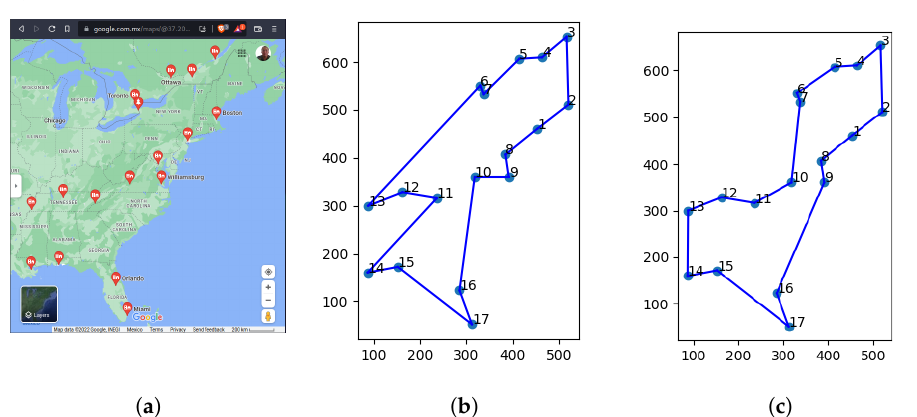
Figure 30. Map and solution of instance “ EastUSA.tsp ”. ( a ) Map [55]; ( b ) Solution; ( c ) Improved solution.